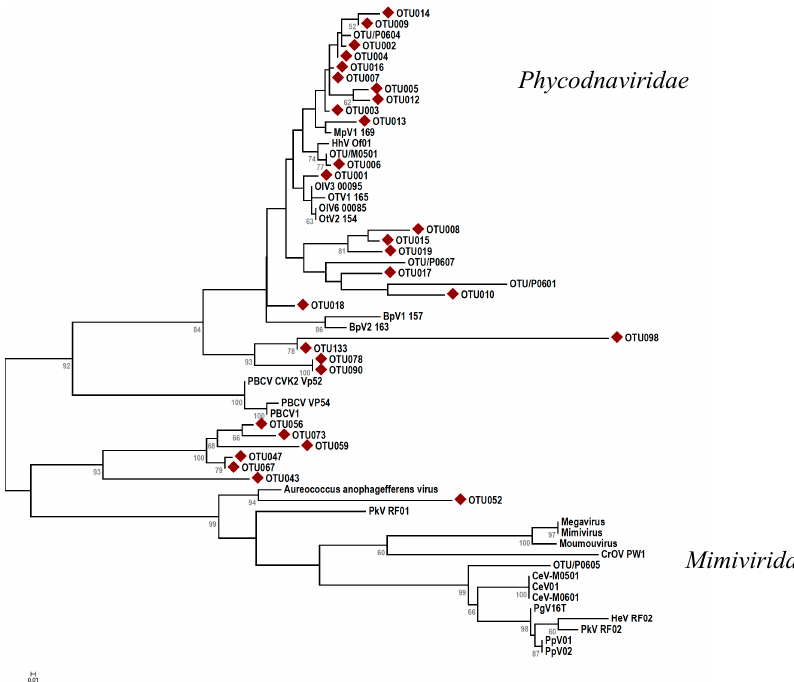
Figure 9. Maximum likelihood tree constructed from the 29 most abundant MCP OTUs ( ). The evolutionary history was inferred using the maximum likelihood method based on the JTT matrix-based model [54] with 100 bootstraps. Branch lengths indicate the number of amino acid substitutions per site. Abbreviations: CroV = Cafeteria roenbergensis virus; Moumou = Moumouvirus goulette; Mimi = Mimivirus; Mega = Megavirus chiliensis; AaV = Aureococcus anophagefferens virus; PoV = Pyramimonas orientalis virus; PkV = Prymnesium kappa virus; HeV = Haptolina ericina virus; HhV = Haptolina hirta virus; CeV = Chrysochromulina ericina virus; PgV = Phaeocystis globosa virus; PpV = Phaeocystis pouchetii virus; PBCV = Paramecium bursaria chlorella virus; MpV = Micromonas pusilla virus; OsV = Ostreococcus sp. virus; OlV = Ostreococcus lucimarinus virus; BpV = Bathycoccus prasinos virus. Scale bar represents 0.2 substitutions per site.